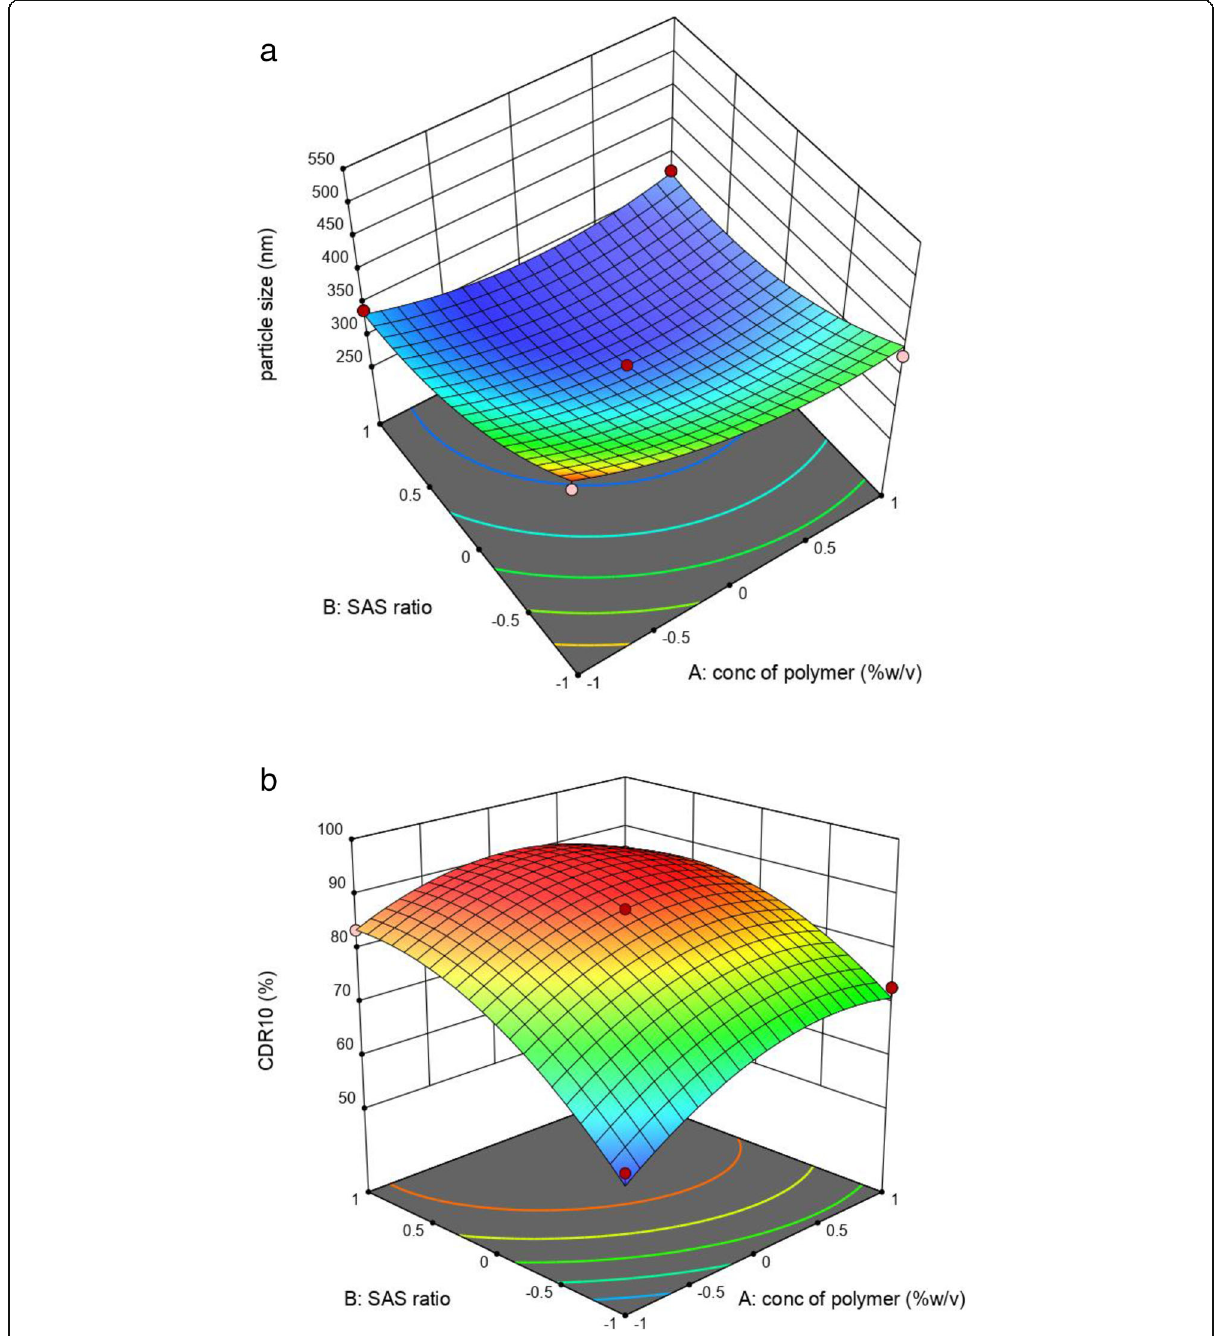
Fig. 4 Response surface plot: effect of interaction between A and B on a (Y1 particle size) and b (Y2